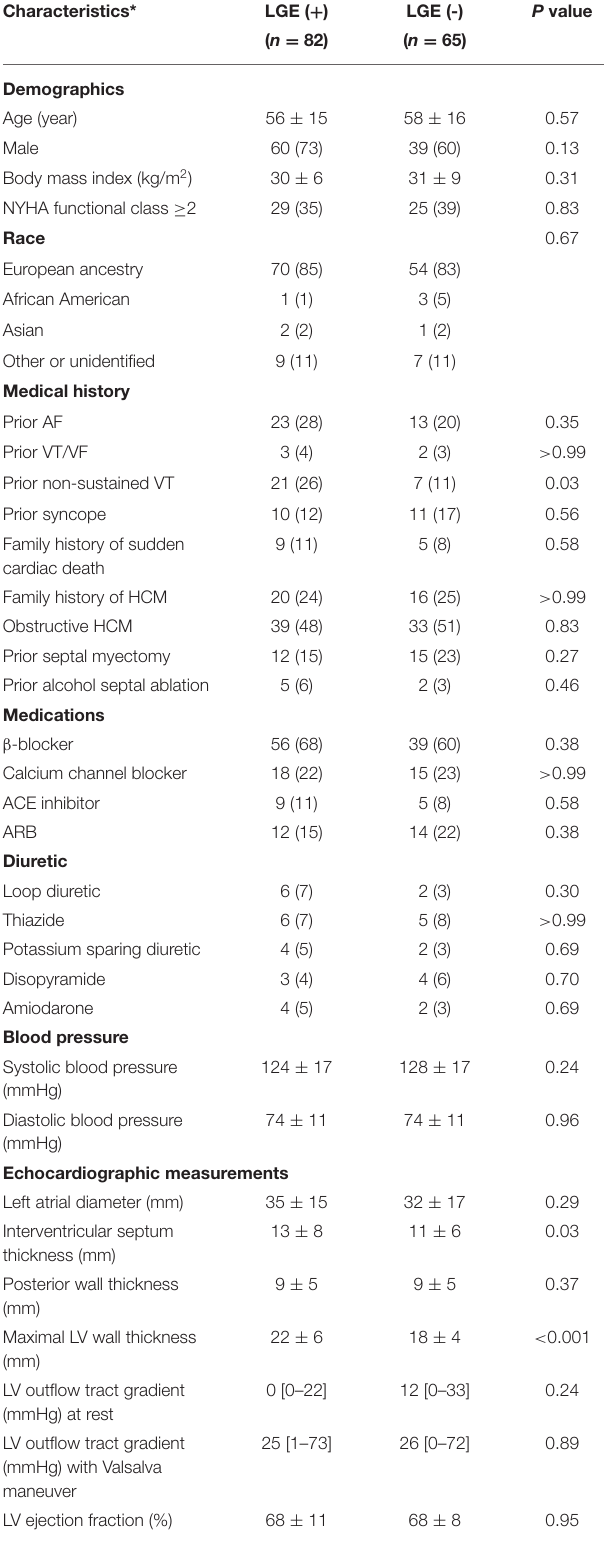
TABLE 1 | Baseline clinical characteristics of the study